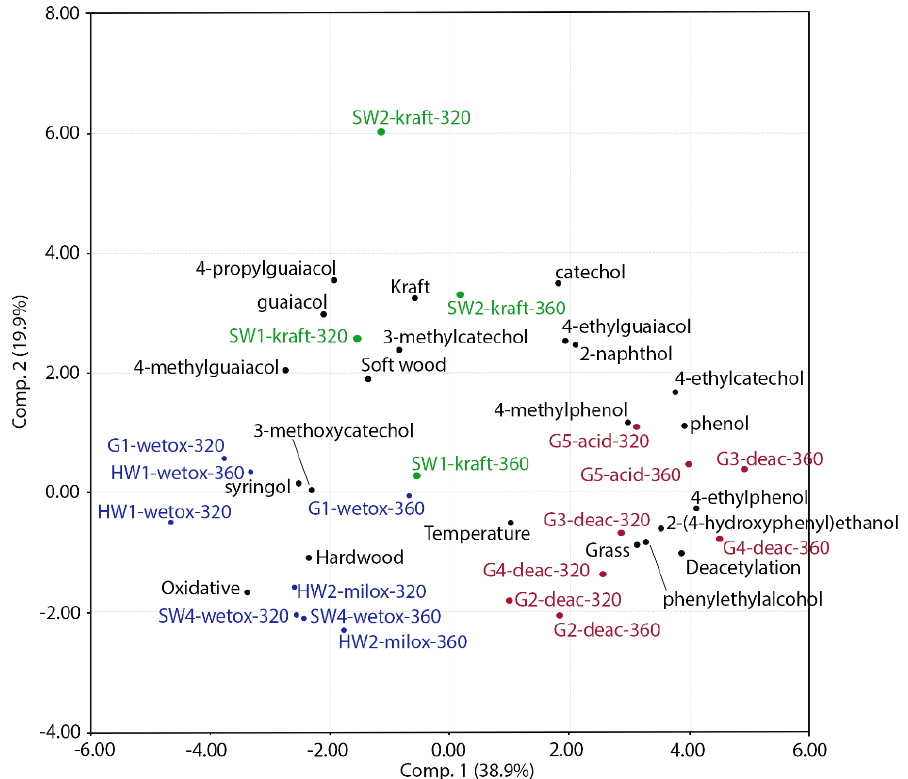
Figure 11. Biplot containing all variables and all experiments from this work. Experiments done with kraft-lignin are marked in green, the blue experiments are done with lignin from oxidative preprocessing, and the red experiments are performed with lignin from a deacetylation preprocessing.